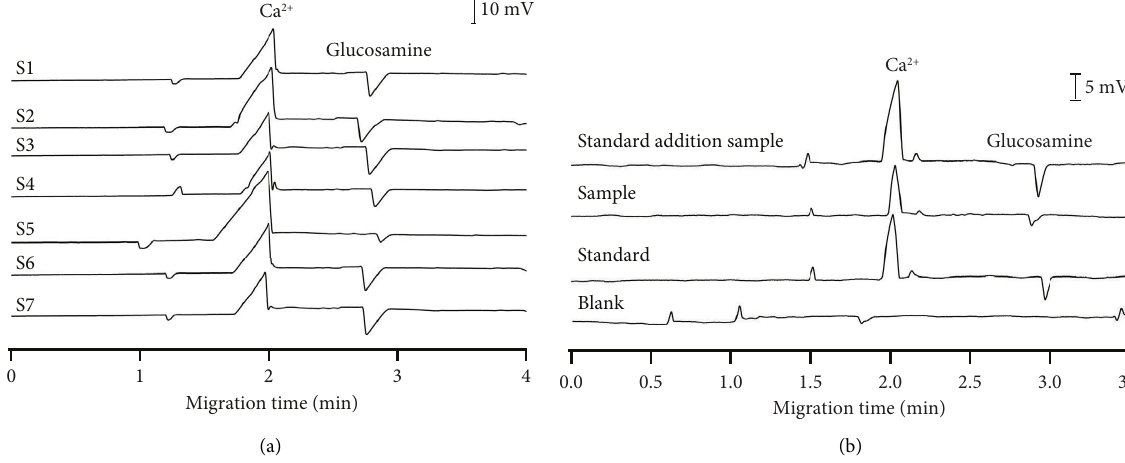
Figure 6: Representative CE-C 4 D electropherograms of (a) diferent supplement samples (Table 1). (b) Specifc peaks evaluated by blank, standard, sample, and standard addition sample. BGE conditions: 10mM Tris/Ace electrolyte solution, pH of 5.0, separation voltage of +20kV, sample injection time of 30s, sample injection height of